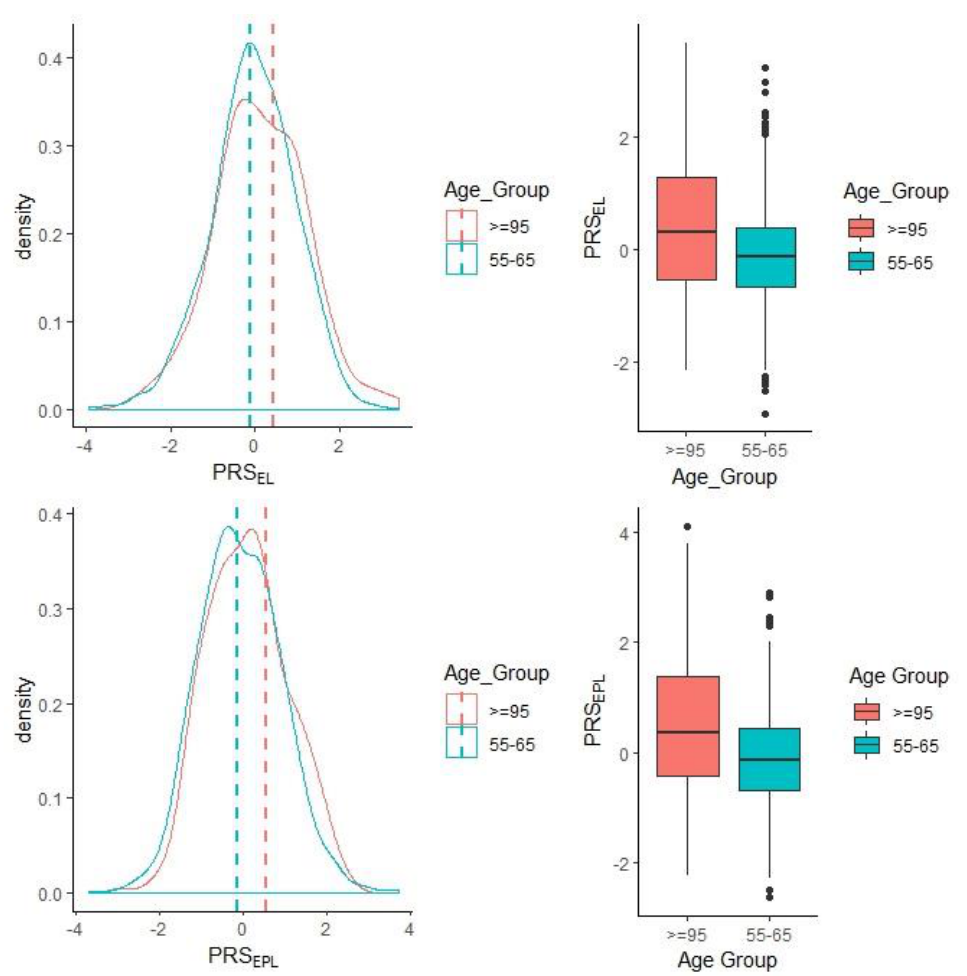
Figure 1. Density plots visualizing the standardised PRS distributions for EL (exceptional longevity, PRSEL) and EPL (exceptional parental longevity, PRSEPL) in the entire sample and the corresponding box plots in the long-lived cases (95+ years) versus controls (55 – 65 years).